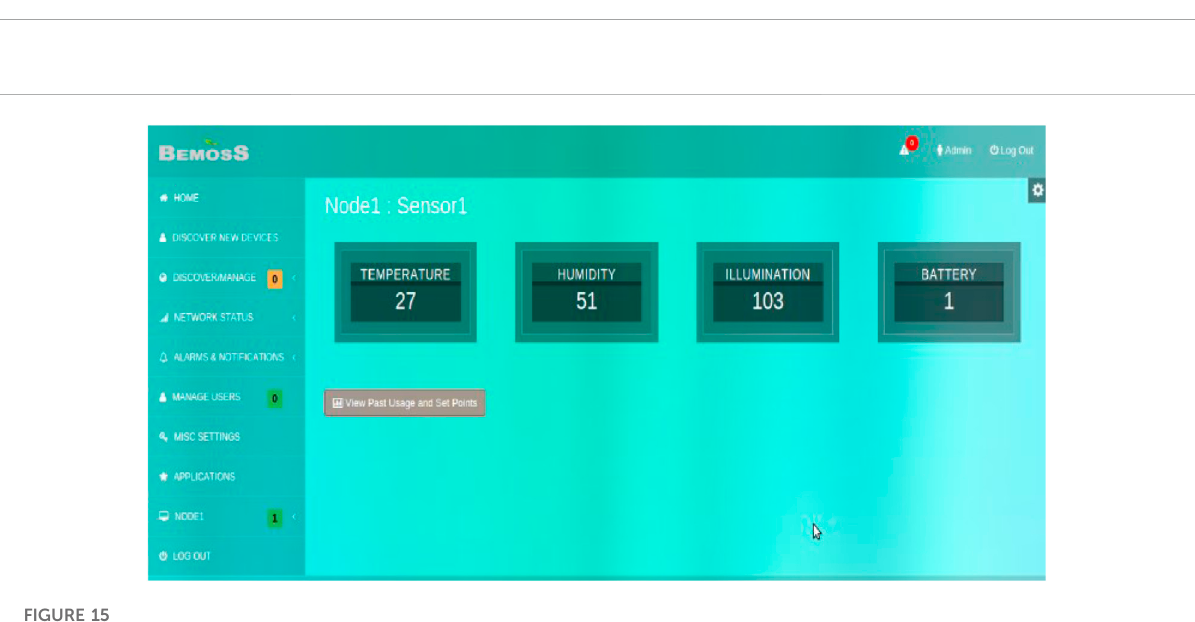
FIGURE 15 Sensor data shown in BEMOSS